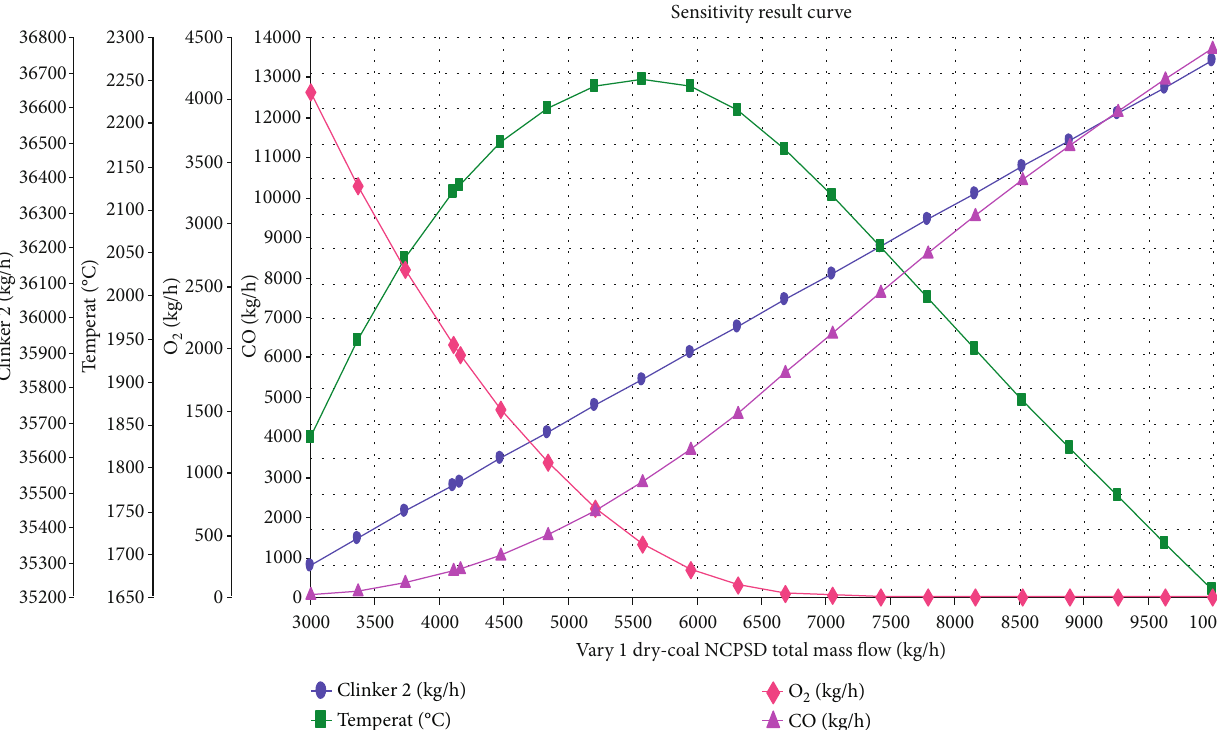
Figure 5: Coal fl ow rate vs. combustion e ffi ciency and clinker production. Horizontal axis indicates coal fl ow rate and vertical axis indicates , and CO clinker, temperature, O 2